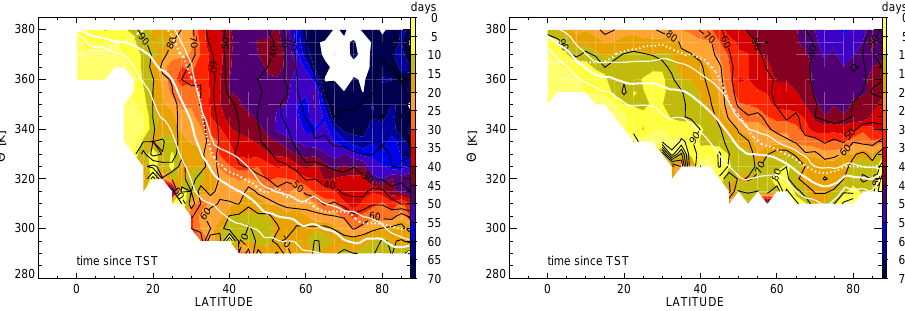
Fig. 3. Zonal mean distribution of t TST on 1 February (left) and 1 August 2008 (right), respectively, when trajectories were initialised. The gradient from yellow to blue indicates increasing t TST with distance to the tropopause ( t TST = 0). Black contours indicate the fraction of TST trajectories in percent. The dotted white line indicates the zonal mean thermal tropopause, solid white lines indicate the location of the 3.5 PVU isosurface with standard deviation for the respective days.